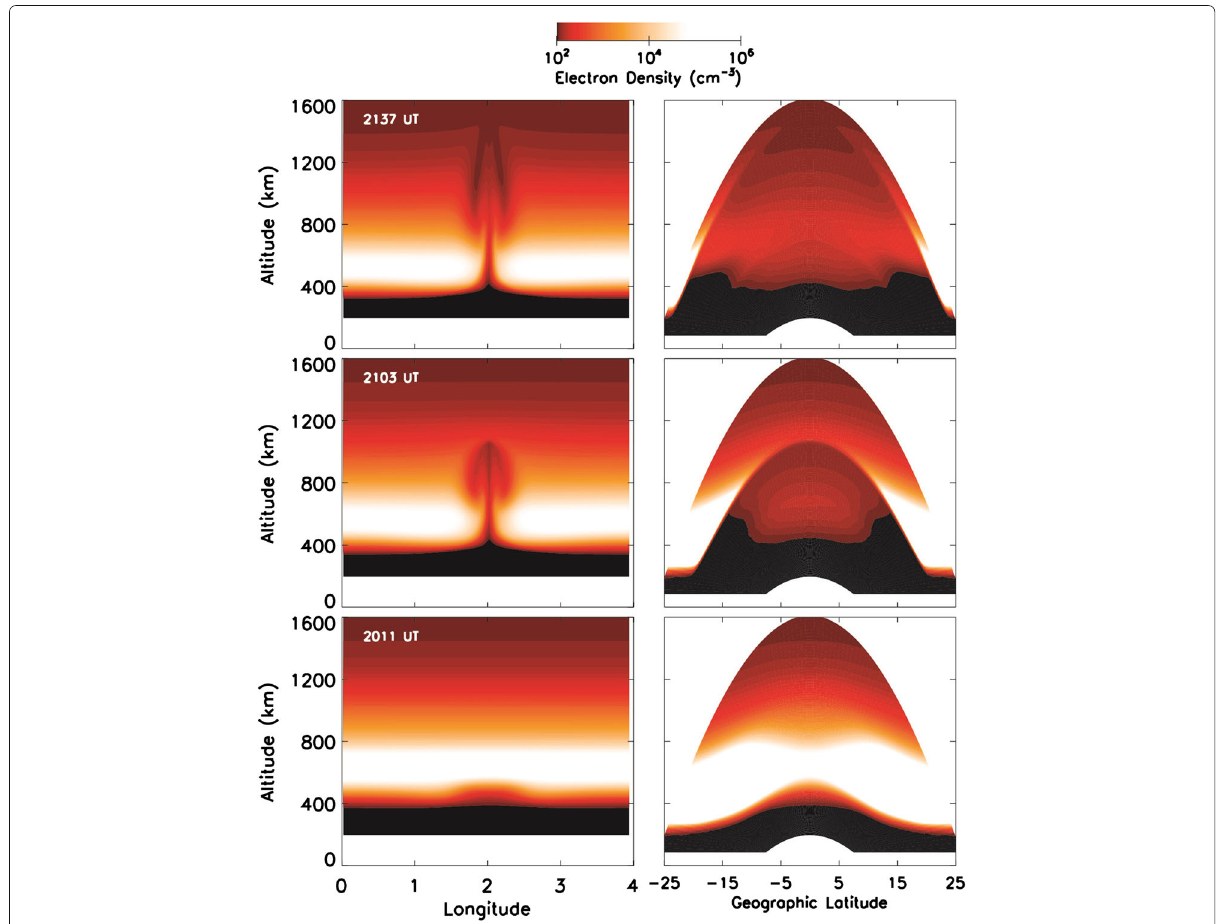
Fig. 5 The first full 3D simulation of EPBs. The geographic and geomagnetic latitudes coincide with each other. Reproduced from Huba et al. (2008)